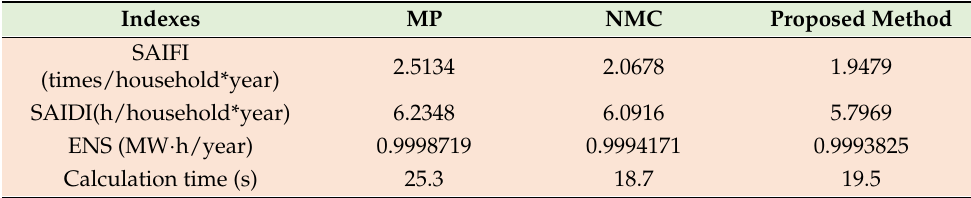
Table 4. Comparison of calculation by three algorithms under scenario